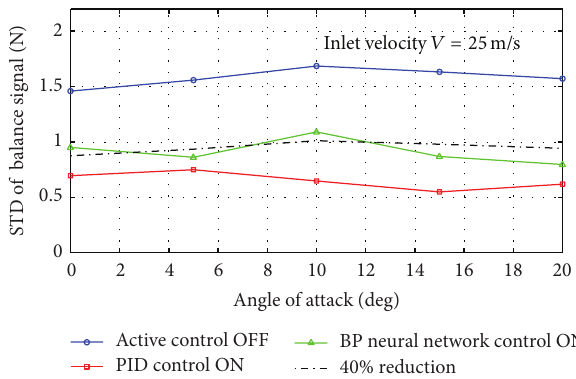
Figure 20: Plots of active damper pitch performance throughout an angle of attack sweep, balance signal STD versus angle of attack with active control ON/OFF.